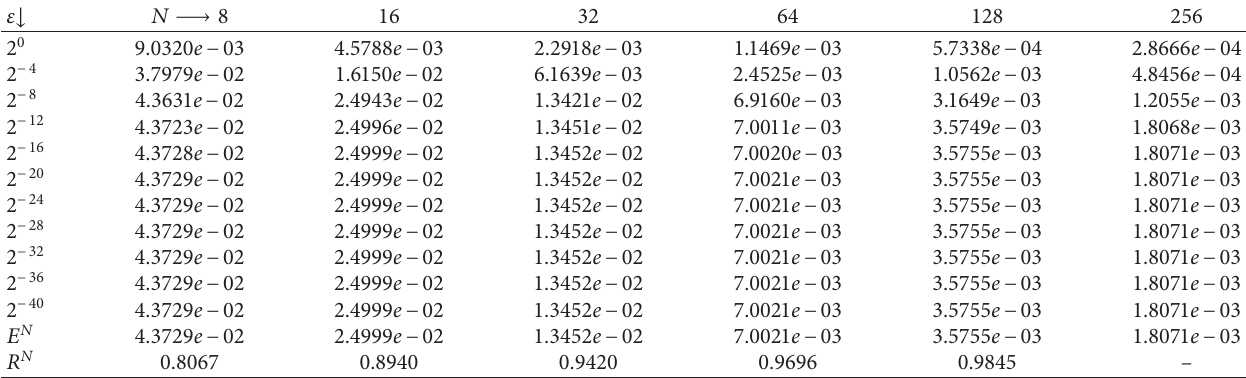
Table 7: Maximum absolute error of Example 4 before Richardson extrapolation for δ � 0 . 6 ε and η � 0 . 5 ε .